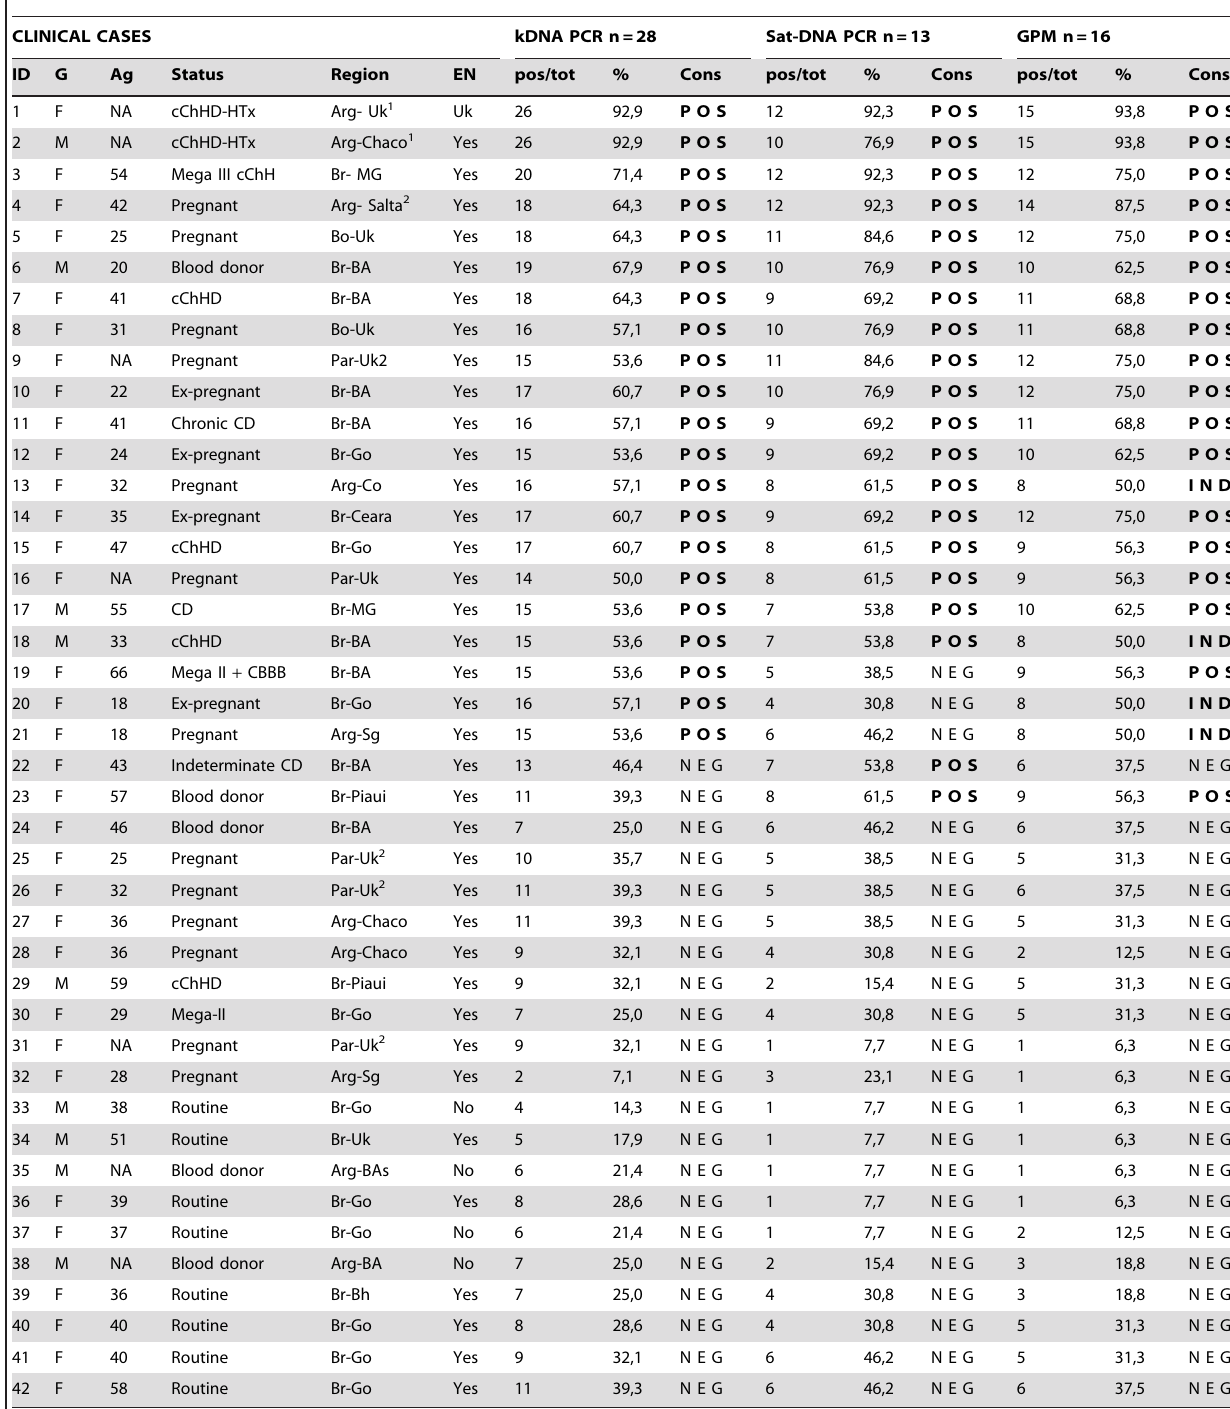
Table 3. Concordance of PCR results reported for each clinical case of Set